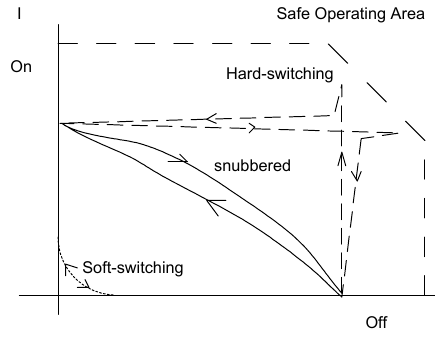
Figure 10. Hard and soft switching characteristics.